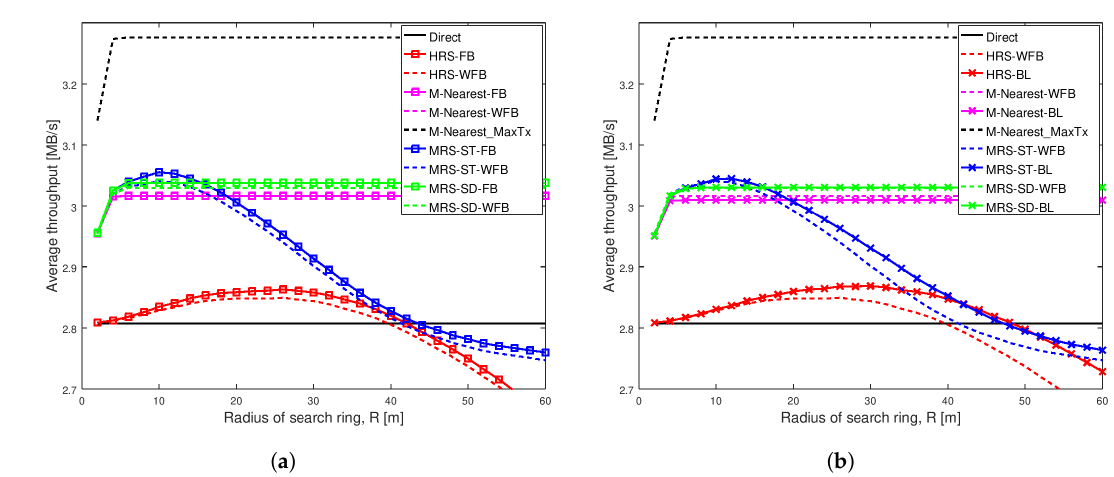
Figure 4. Average throughput of different schemes when Shape = 1.01 and Scale = 0.01 in a network having width of 100 m. ( a ) Different battery power levels not considered in relay selection; ( b ) Different battery power levels considered in relay